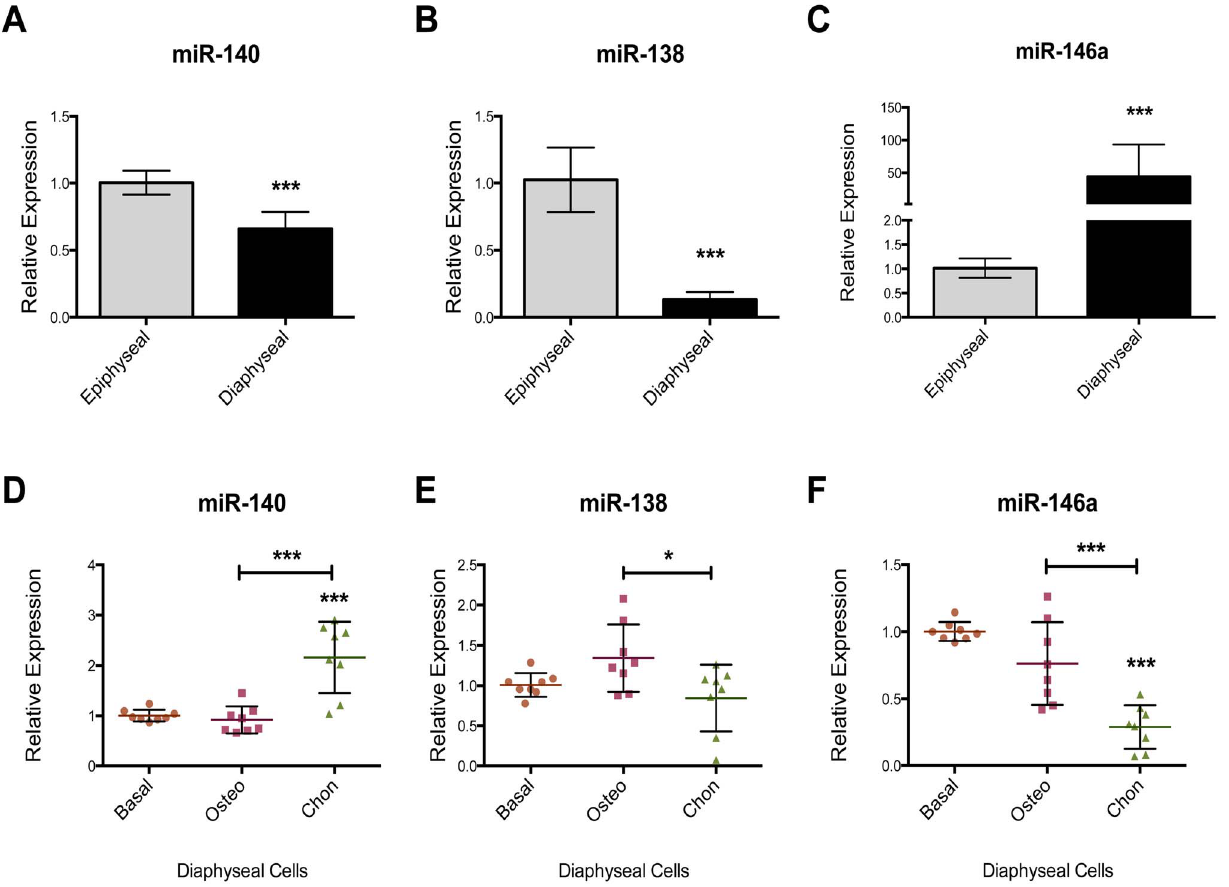
Figure 5. Relative expression (RT-qPCR) of miR-140, miR-138 and miR-146a in epiphyseal and diaphyseal cell populations (A–C) and the effect of differentiation media on expression in diaphyseal cells (D–F). miR-140 was expressed at a higher level in epiphyseal cells (A). miR-138, known to have anti-osteogenic effects was found to have a lower level of expression in diaphyseal cells (B). miR-146a, identified in our microarray, was validated and shown to display a markedly increased expression level in the diaphyseal cell populations compared to epiphyseal cells (C). The use of osteogenic media did not affect the expression levels of miR-140, miR-138 and miR-146a compared to culture in basal conditions (D– F). Chondrogenic culture conditions resulted in increased expression of miR-140 while miR-146a expression was suppressed (D–F). Relative expression was normalized to MAMM-U6 with epiphyseal cells (A–C) and basal condition (D–F) set to an expression of one. Data represent an average of three independent patient samples and error bars represent standard deviation. * P , 0.05; ** P , 0.005; *** P , 0.001 calculated using Mann-Whitney (A–C) and ANOVA test (D–F).